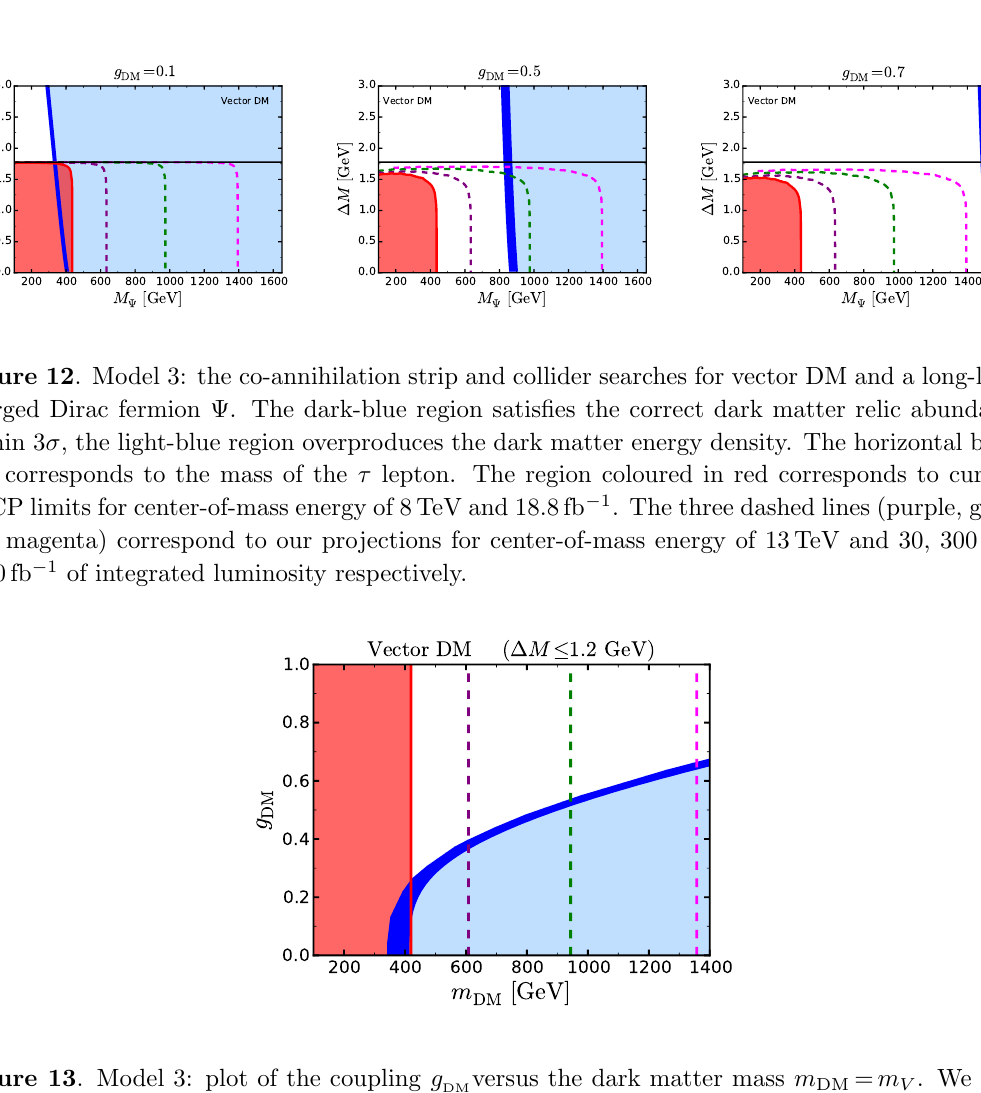
Figure 13 . Model 3: plot of the coupling g versus the dark matter mass m DM = m V . We scan DM over (cid:1) M [0 ; 1 : 2 GeV], where (cid:1) M = M (cid:9) m V , this is the mass region where the HSCP limits 2 (cid:0) are independent of the coupling g . The dark blue band satis(cid:12)es the correct DM relic abundance DM within 3 (cid:27) , the region in light blue overproduces the amount of DM. The colour-coding for the exclusion regions is the same as in the previous